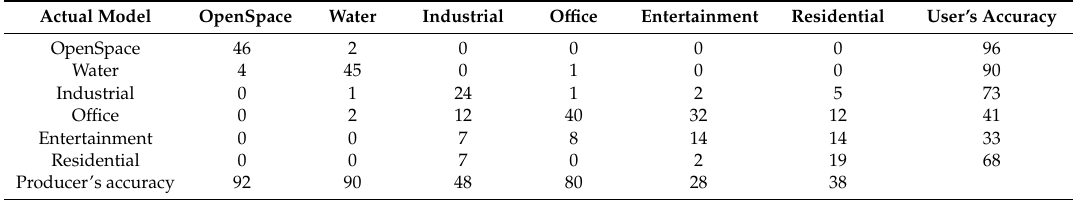
Table A4. Confusion matrix of random forest classified map using remote sensing